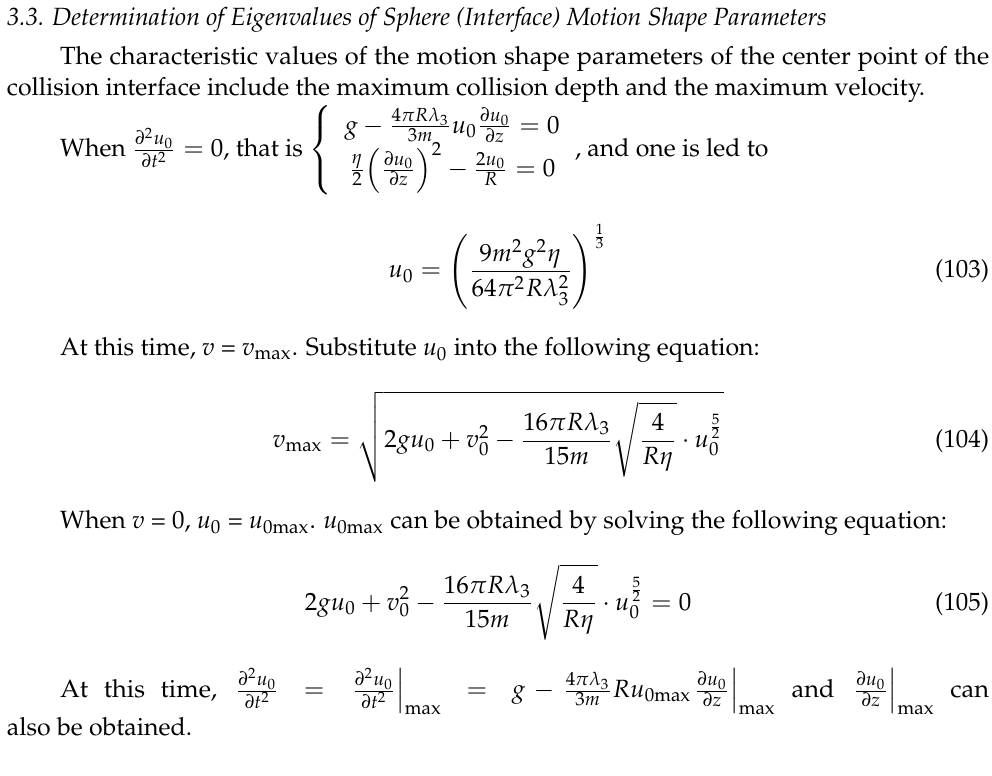
Figure 5. The array diagram of the excited waves at the collision interface.